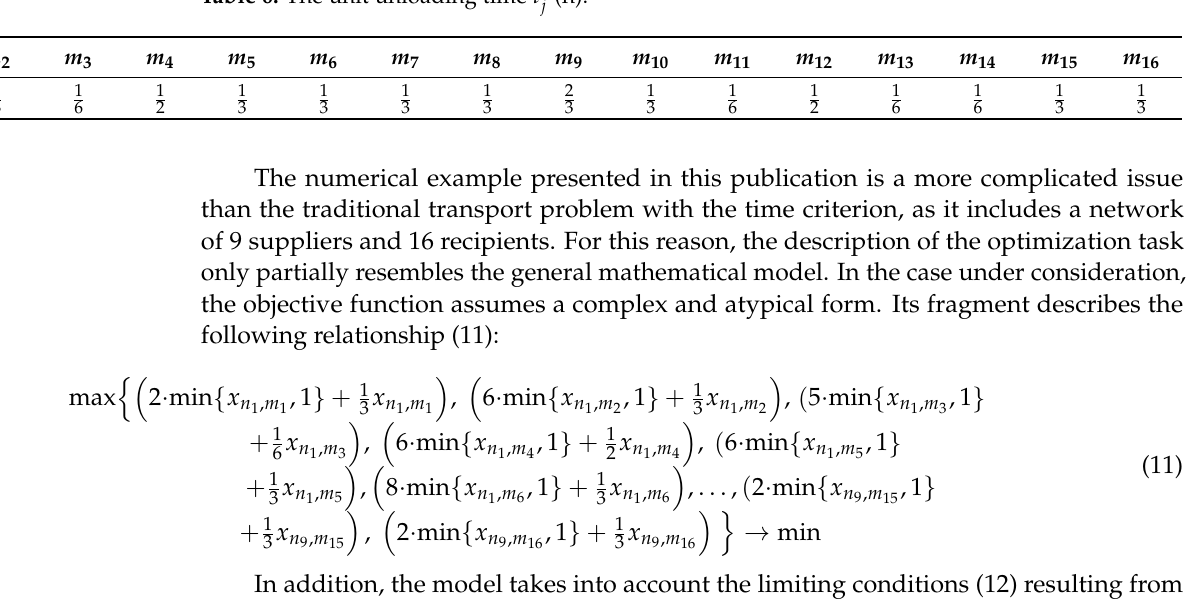
Table 6. The unit unloading time t r